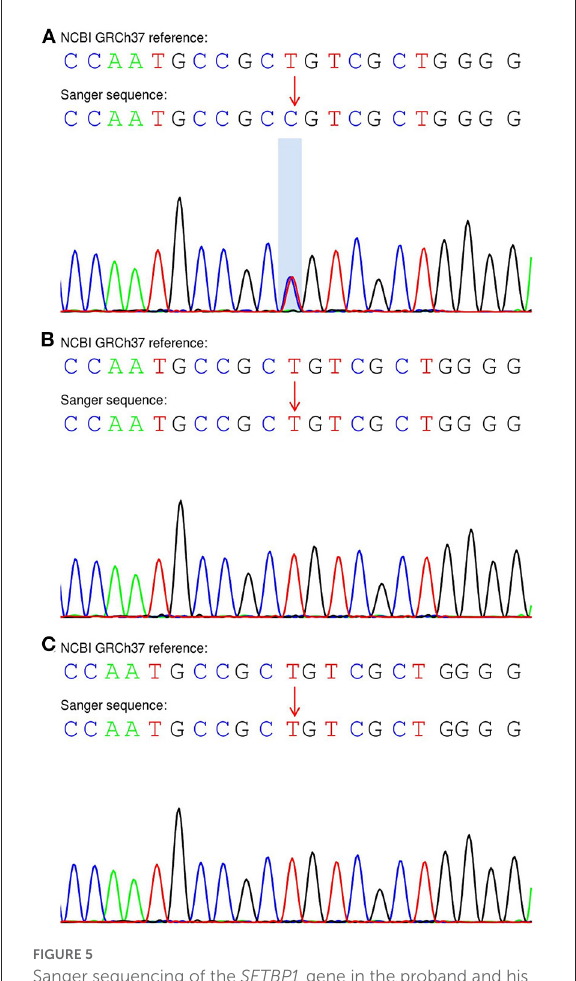
FIGURE5 Sanger sequencing of the SETBP1 gene in the proband and his parents. (A) The patient exhibited a heterozygous variant (c.2605A > G:p.S869G). (B,C) His unaffected parents carried the wild-type